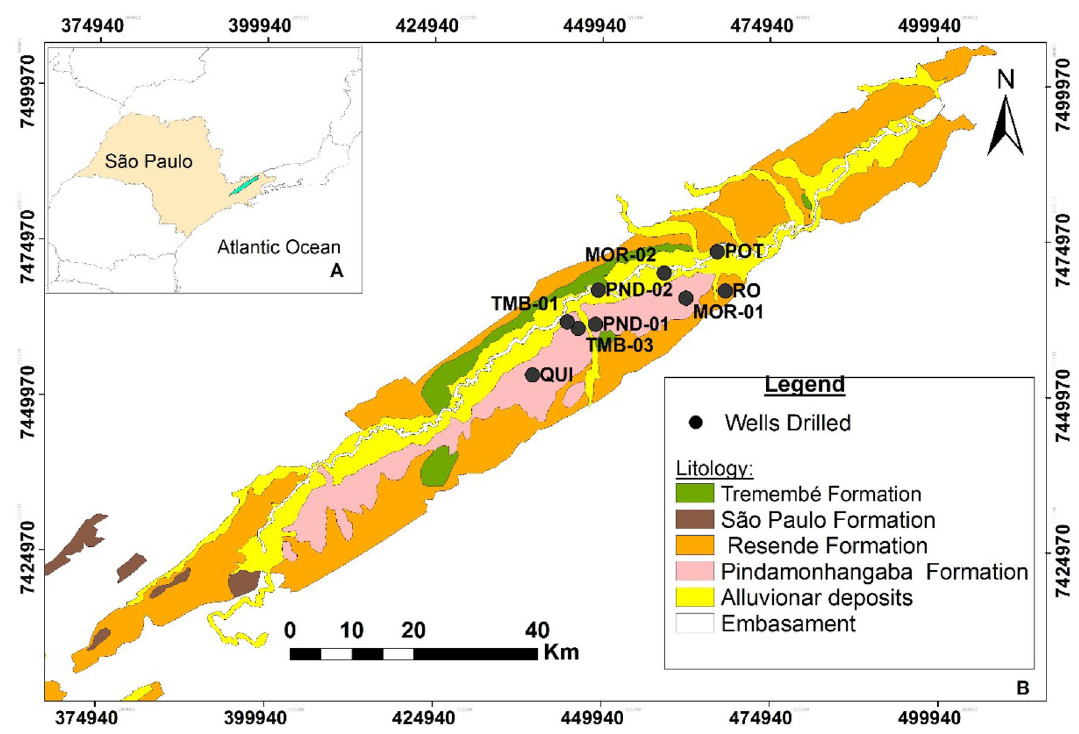
Fig. 1 a Map showing the location of the Taubaté Basin. b Simplified geological map of Taubaté Basin, showing the wells studied Source modi- fied from Riccomini